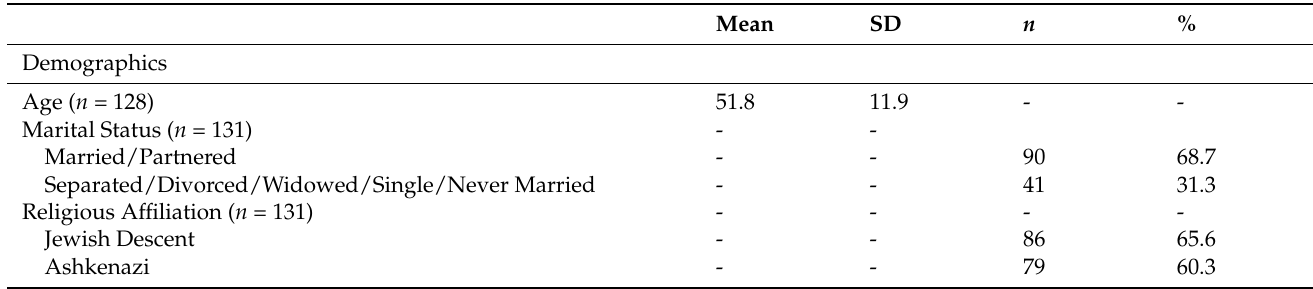
Figure 1. Multidimensional components of satisfaction with HBOC-related social media ( n = 131). Table 1. Characteristics of social media users among annual evaluation survey respondents ( n = 131) *.